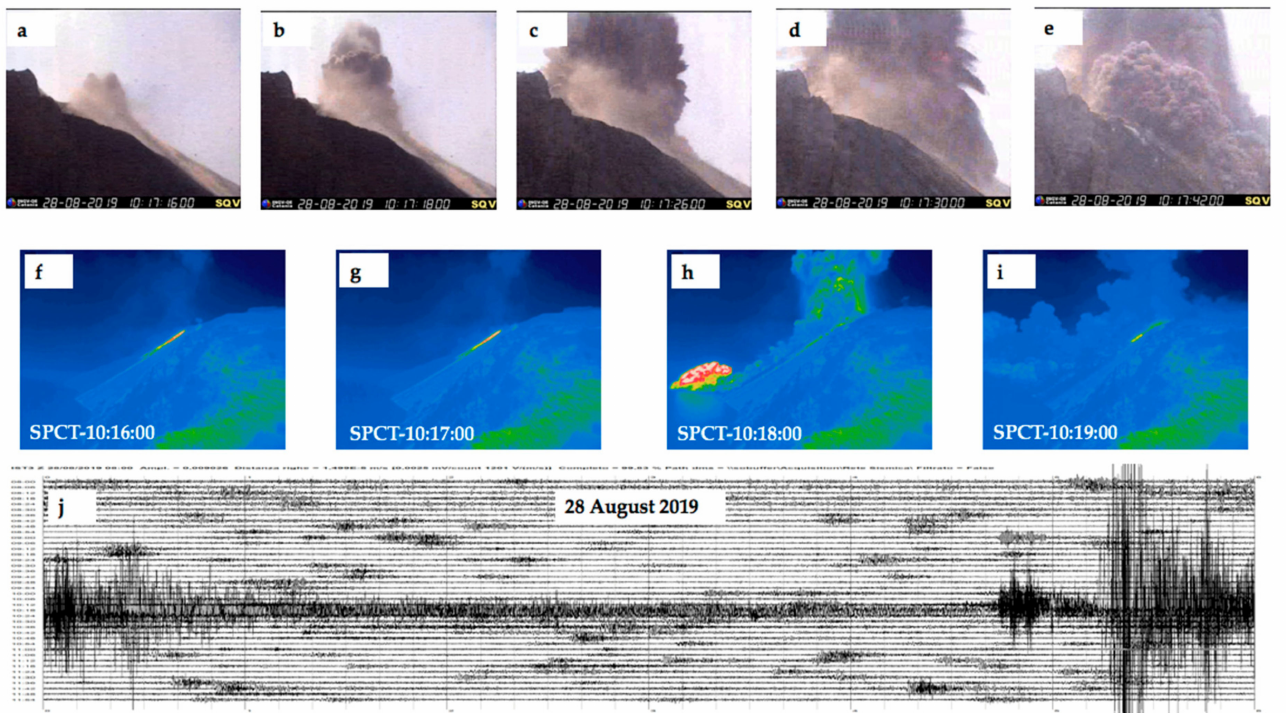
Figure 7. ( a – e ) Visual images from the SQV camera of the 28 August 2019 event recorded at 10:17:16 ( a ), 10:17:18 ( b ), 10:17:26 ( c ), 10:17:30 ( d ), and 10:17:42 ( e ), view from NE. ( f , i ) Thermal images from the SPCT camera, showing ( f ) the lava flow from the crater zone at 10:16:00 and at 10:17:00 ( g ), the eruptive column and PDC spreading over the sea surface for ~300 m at 10:18:00 ( h ), and the ash cloud at 10:19:00 ( i ), view from W. Blue is cold, white is hot. ( j ) Seismic trace of the 28 August explosive paroxysm as recorded from the IST3 seismic station, Z component. See Figure 1 for station